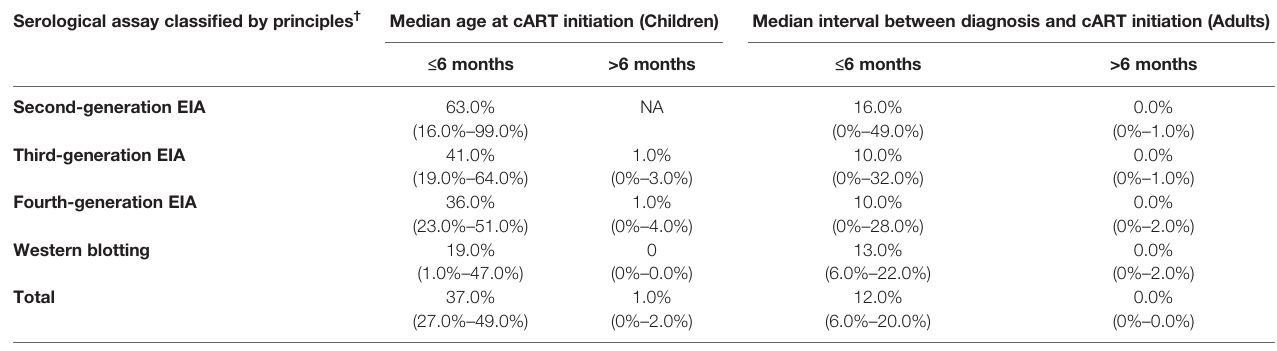
TABLE 4 | The pooled frequency of seronegativity (95% CI) for HIV-1 serological EIA assays in cART-treated population strati fi ed by detection principles and timing of antiretroviral therapy started. Serological assay classi fi ed by principles † Median age at cART initiation